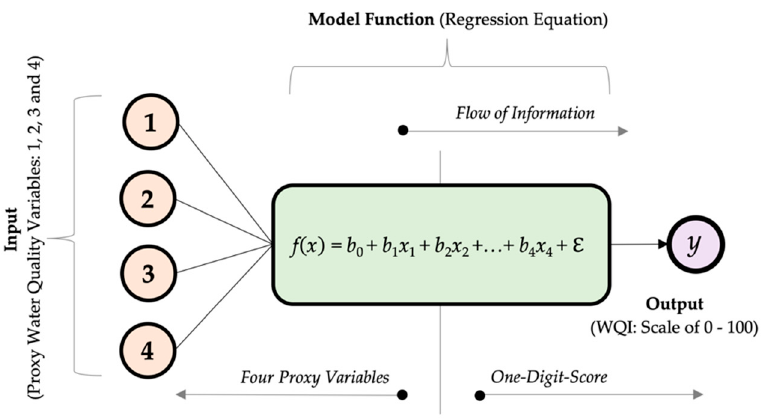
Figure 3. Model architecture applied in the development of the surrogate water quality index model using four proxy water quality variables. A model outline displaying the structure of the surrogate WQI with four proxy water quality input variables x 1 , x 2 , x 3 and x 4 ; their corresponding coefficients b 1 to b 4 , intercept term b 0 , error term for the regression model symbolized as ε , and the regression model function f ( x ) = b 0 + b 1 x 1 + b 2 x 2 + ... + b 4 x 4 + ε as the surrogate WQI.